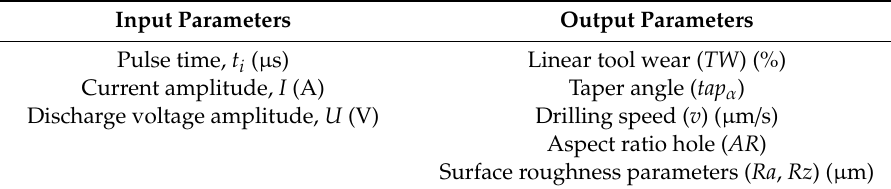
Figure 2. A photograph of the experimental setup. Table 3. Machining parameters.